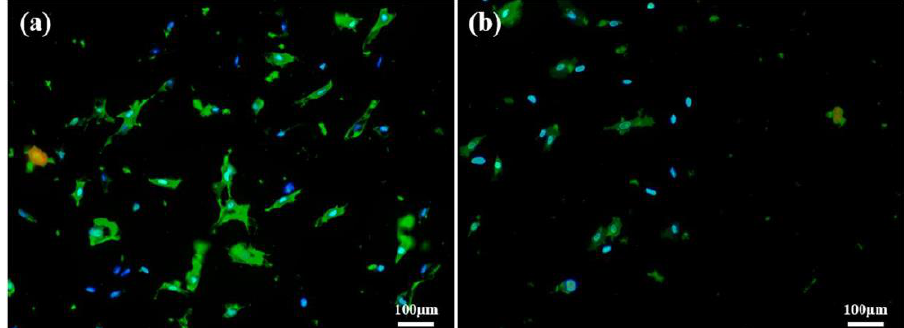
Figure 12. 3T3 cells attachment test on the ( a ) pristine PDMS and ( b ) PDMS-PMPC substrates.